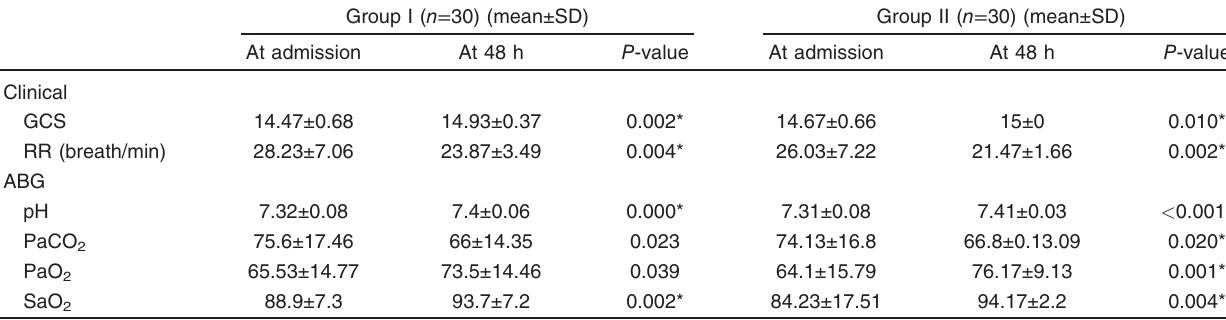
Table 6 Changes in Glasgow Coma Scale, respiratory rate, and arterial blood gases at 72 h